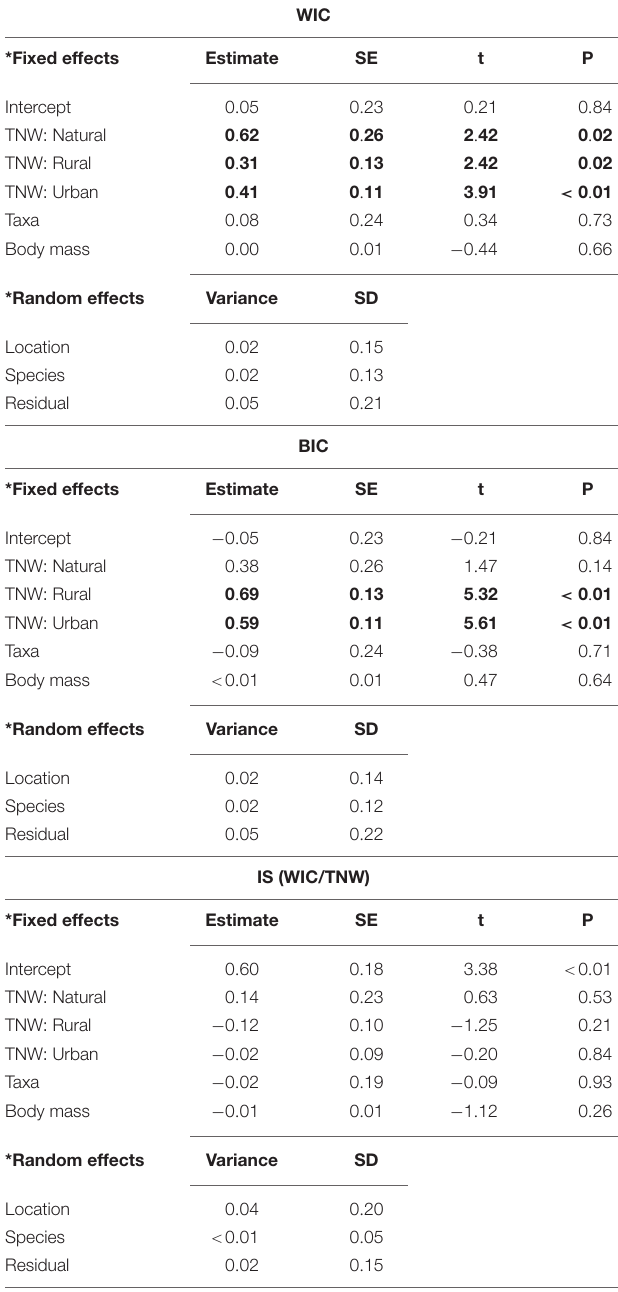
TABLE 2 | Relationships among niche characteristics within